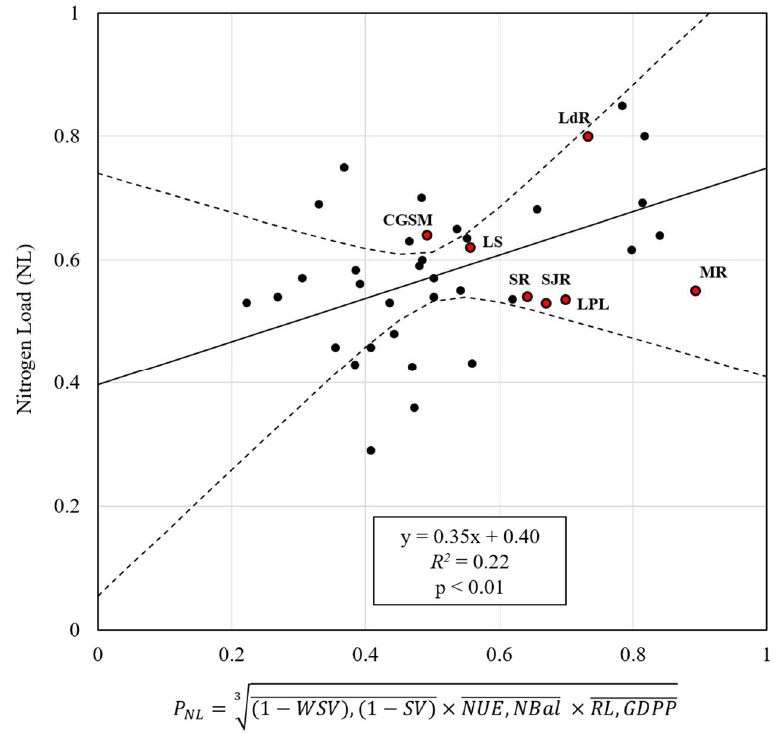
Figure 6. Regression analysis for ecosystem services provided by ecosystem nutrient regulation service threat benchmark N-load (NL; [14]) as a function of proxy ( P NL ) based on external, internal and socioeconomic indicators (Table 2). Regression model (solid line; dashed lines 95% confidence interval) based on Ramsar sites (black circles), with SAFER sites (red circles) plotted for comparison.